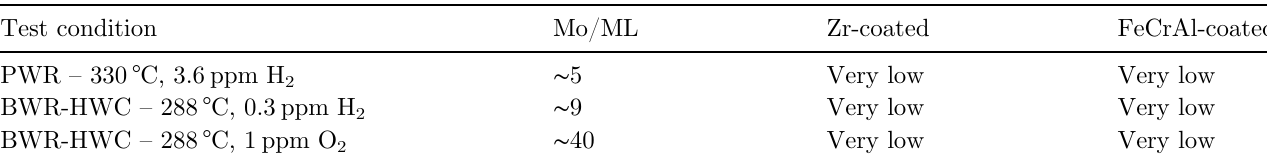
Table 2. Summary of the corrosion rate (in m m per month) of bare and coated Mo-alloy tubes in simulated LWR coolants. Test